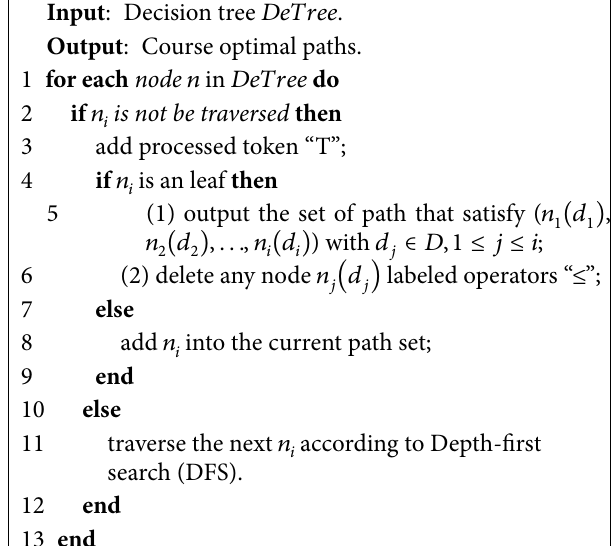
Algorithm 3: CGR: course grouping recommendation